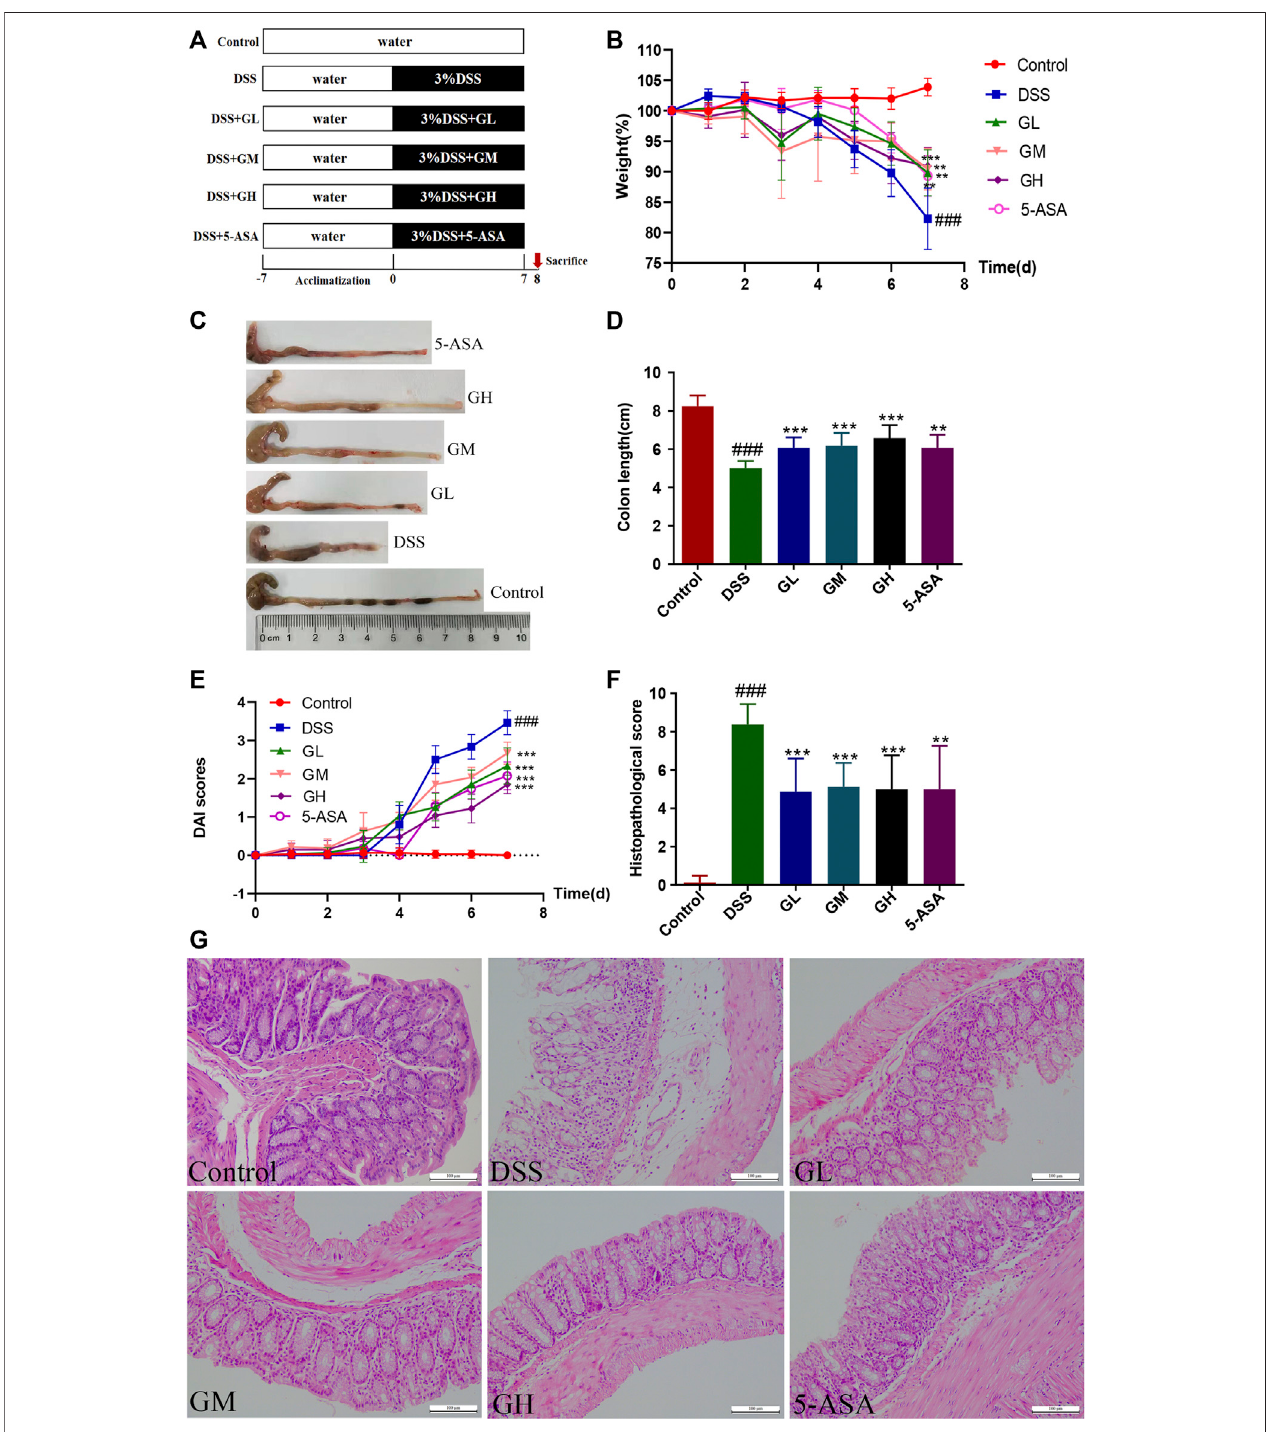
FIGURE1| MGQDinterventionamelioratedDSS-inducedexperimentalcolitisinmice. (A) TheschematicdiagramofUCmodelanddrugtreatment. (B) Percentage change of body weight. (C) Representative photograph of colons. (D) Statistics of colon length. (E) Disease activity index (DAI) score. (F) The histological scores of mouse colon morphology. (G) Representative microscopic pictures of H and E staining (ampli fi cation, × 200). Results were shown as mean ± SD (n (cid:2) 8 – 10). ### p < 0.001, vs control group; ** p < 0.01, *** p < 0.001, vs DSS group.